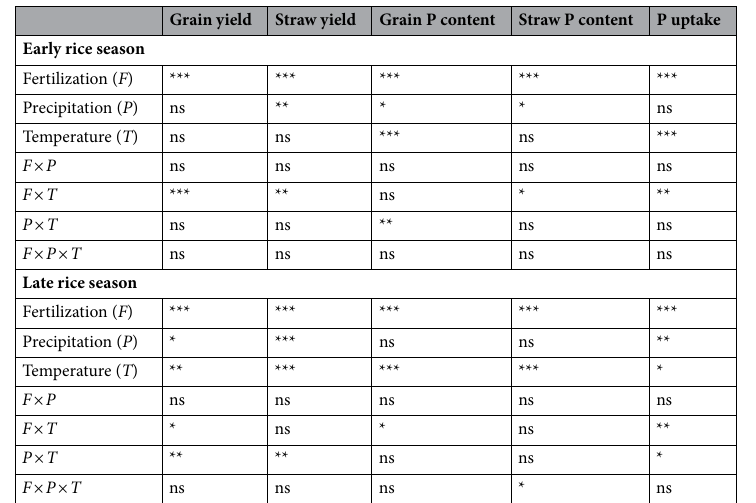
Table 3. Analysis of variance for the effects of fertilization application, precipitation, temperature and the interactions between fertilization and the other variables on grain yield, straw yield, grain P content, straw P content and aboveground P uptake. Precipitation is arbitrarily divided into three levels of < 600, 600–800 and > 800 mm for early rice season; and into three levels of < 150, 150–300 and > 300 mm for late rice season. Temperature (monthly) is arbitrarily divided into three levels of < 23, 23–24 and > 24 ℃ for both the early and late rice season. CK: unfertilized control; NK: mineral fertilizer NK; NPK: mineral fertilizer NPK; NKM: mineral fertilizer NK combined with pig manure, PRE: phosphorus recovery efficiency. ns Not significant at p < 0.05. * Denote significant difference in ANOVA at p < 0.05. ** Denote significant difference in ANOVA at p < 0.01. *** Denote significant difference in ANOVA at p < 0.001.